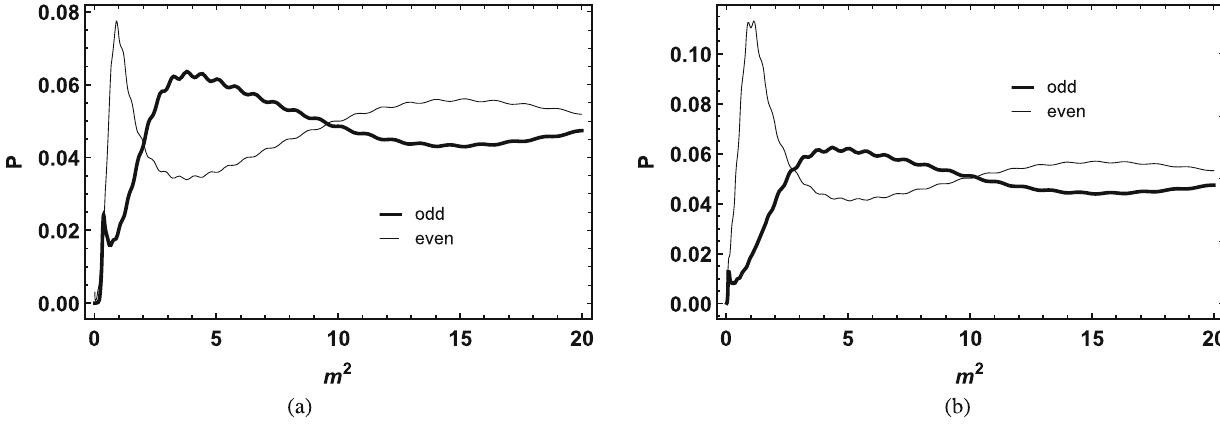
Fig. 17 The behavior of the relative probability P ( m ) for G 2 ( T ) with n = 2, k = − 0 . 05 and p = λ = 1. a Gauge field. b KR field